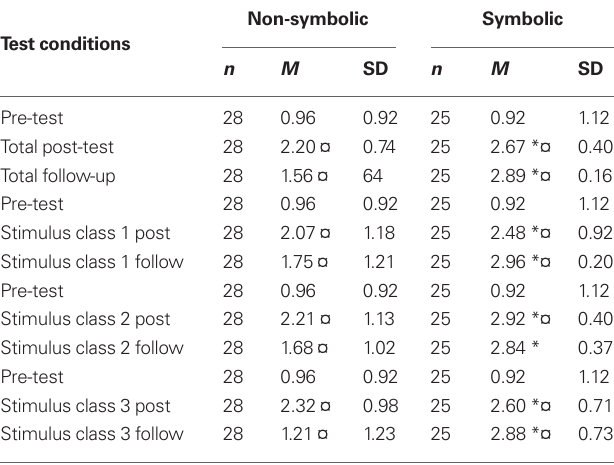
Table 1 | Mean values ( M ) and standard deviations (SD) for scorings concerning the pre-test (bold), total post-test, total follow-up, and stimulus classes (1–3) during post-test, and follow-up in regard to symbolic behavior (non-symbolic versus symbolic).